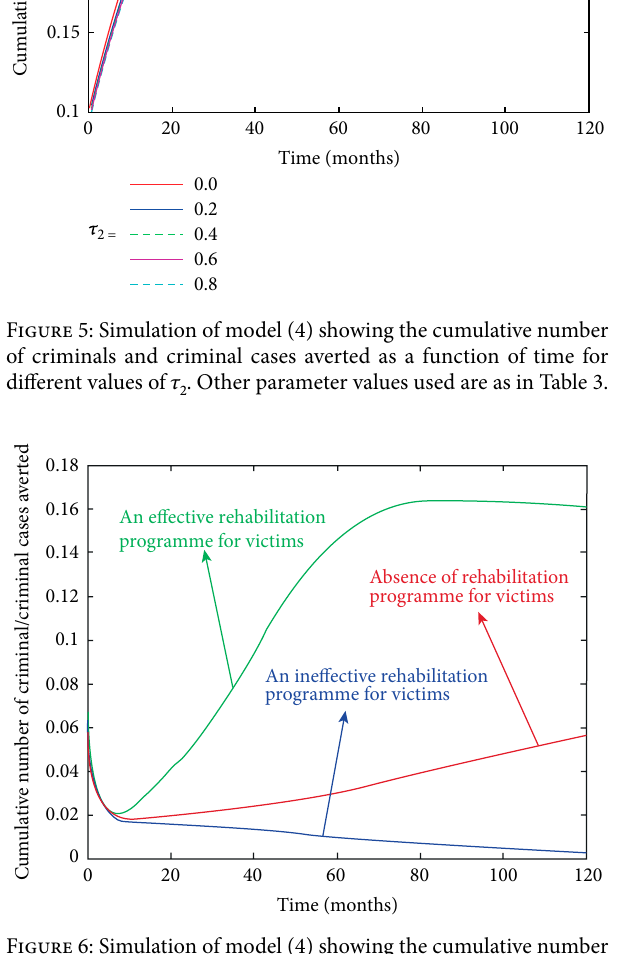
Figure 6: Simulation of model (4) showing the cumulative number of quitting criminals and the corresponding averted criminal cases as a function of time for a combination of variable values of . Other parameter values used are as in Table 3. 𝜓 2